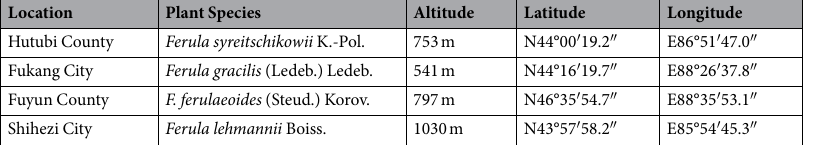
Table 1. Description of the four sampling locations in the northern part of the Xinjiang Uygur Autonomous Region,